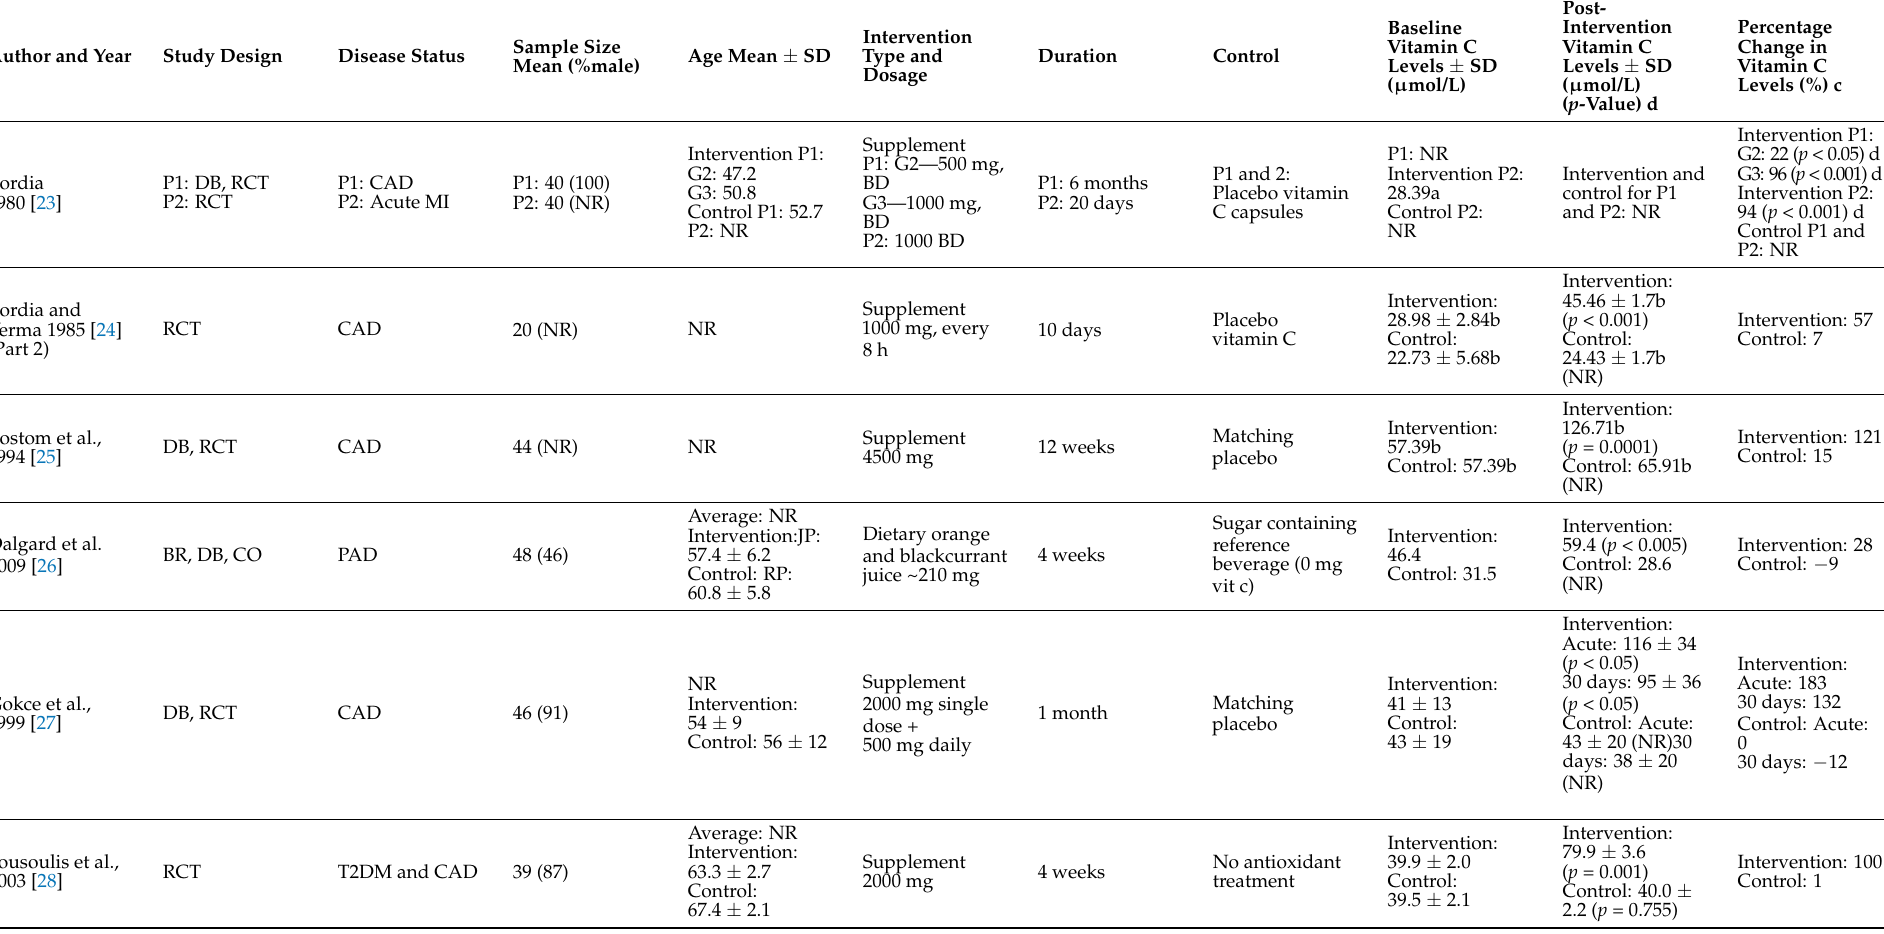
Table 3. Data summary table of studies investigating vitamin C intake and vitamin C levels in CVD